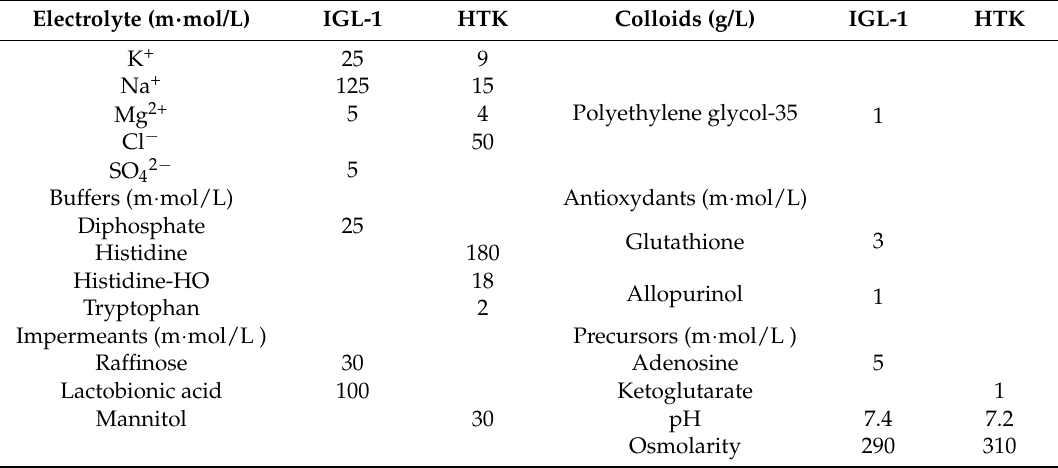
Table 1. Comparison between histidine-tryptophan-ketoglutarate (HTK) and Institute Georges Lopez (IGL-1) preservation solutions